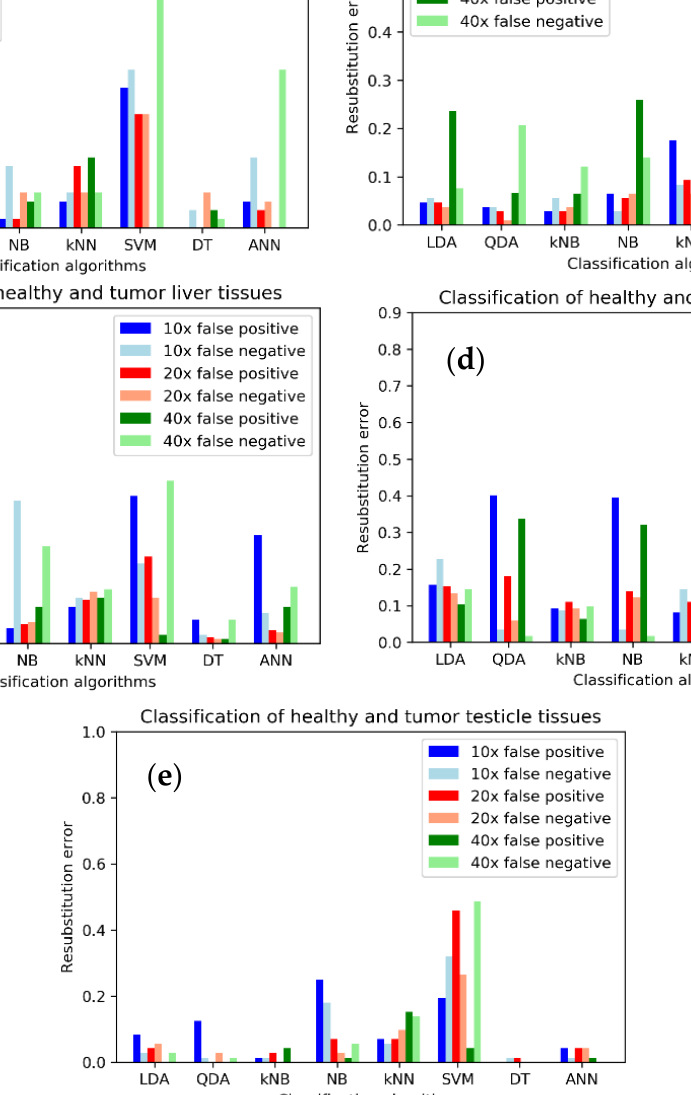
Table 4. Results of the cross-validation error, expressed separately for the false positive and false negative rates, for each tissue type and magnification. Combinations with total cross-validation er- ror (FP + FN) < 0.1 are marked in bold.